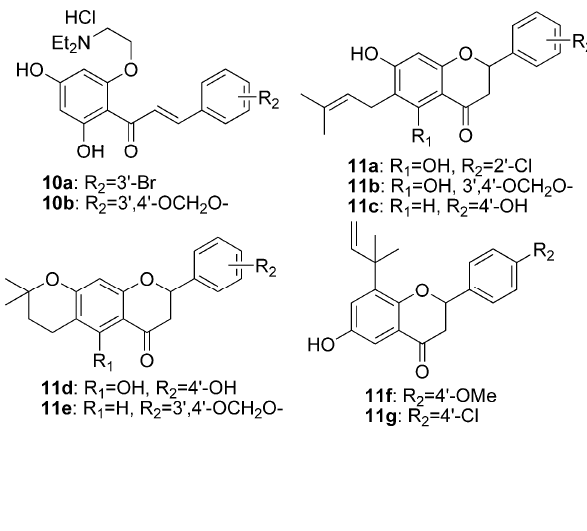
Figure 2. The structures of the target flavonoids synthesized in this